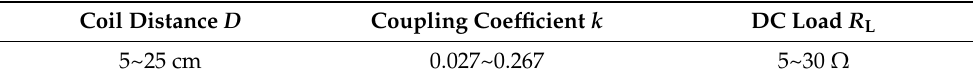
Table 2. Experimental